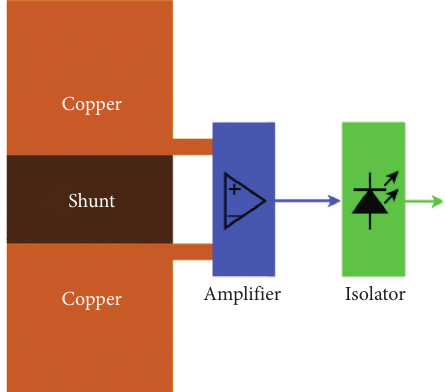
Figure 7: A shunt resistor-based current sensor with amplifer and isolator.